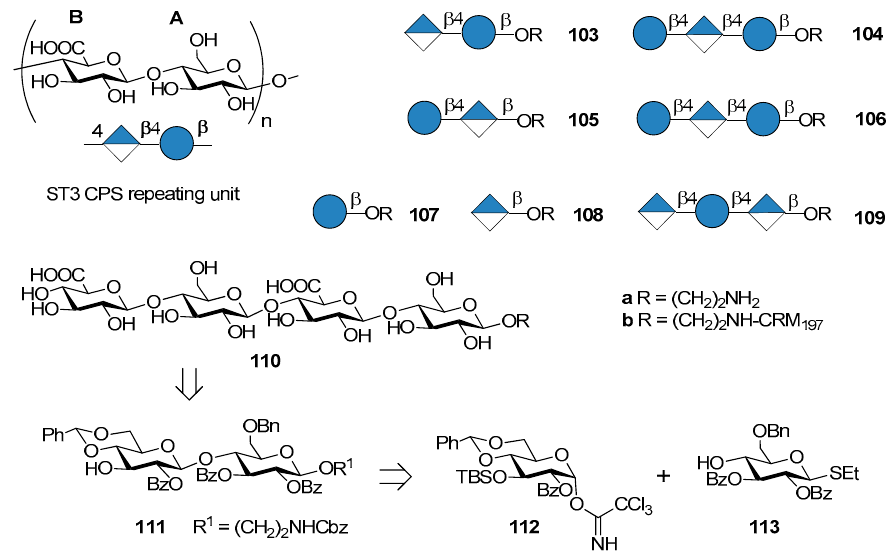
Figure 12. Repeating unit of Streptococcus pneumoniae 3 CPS and synthetic ST3 glycan fragments reported in [81].